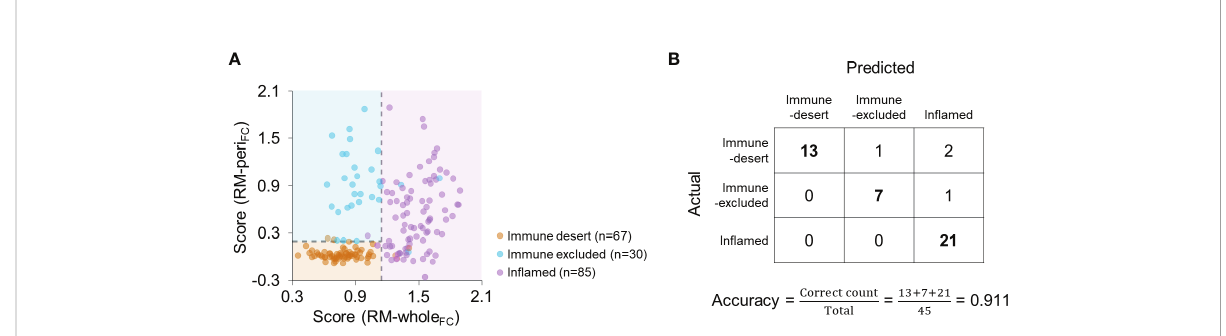
FIGURE 5 Combination of RM-whole FC and RM-peri FC to predict the immunophenotype. (A) The scores obtained from RM-whole FC and RM-peri FC according to the immunophenotype. The dashed lines indicate the optimal cutoff for each RM. (B) Confusion matrix for the combination of RM- whole FC and RM-peri FC in the validation